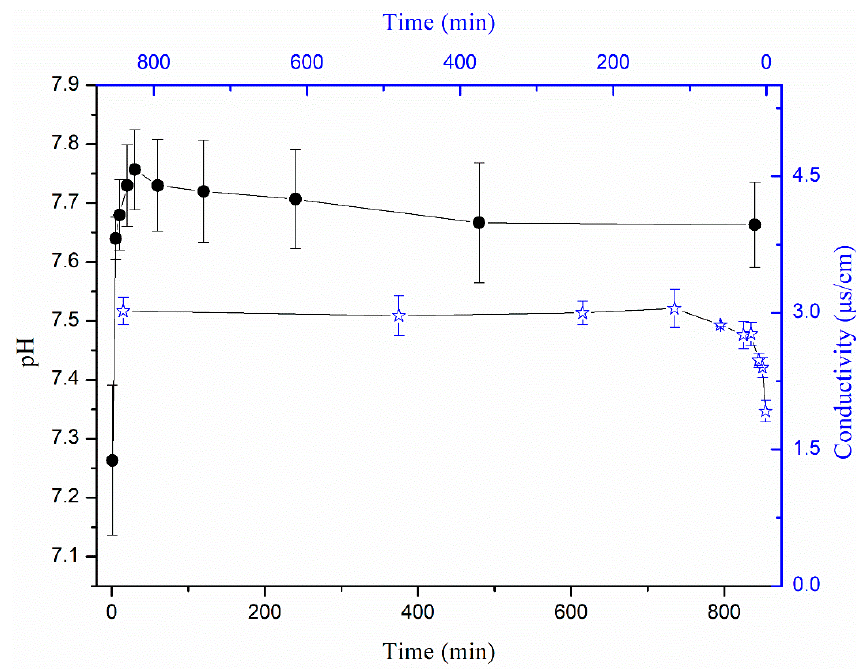
Figure 3. Variation in pH and conductivity of the solution as a function of shaking time.